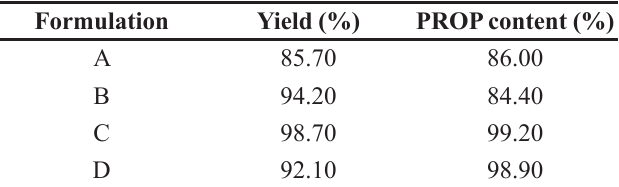
TABLE V - Results of yield and content of PROP found for the formulations from A to D